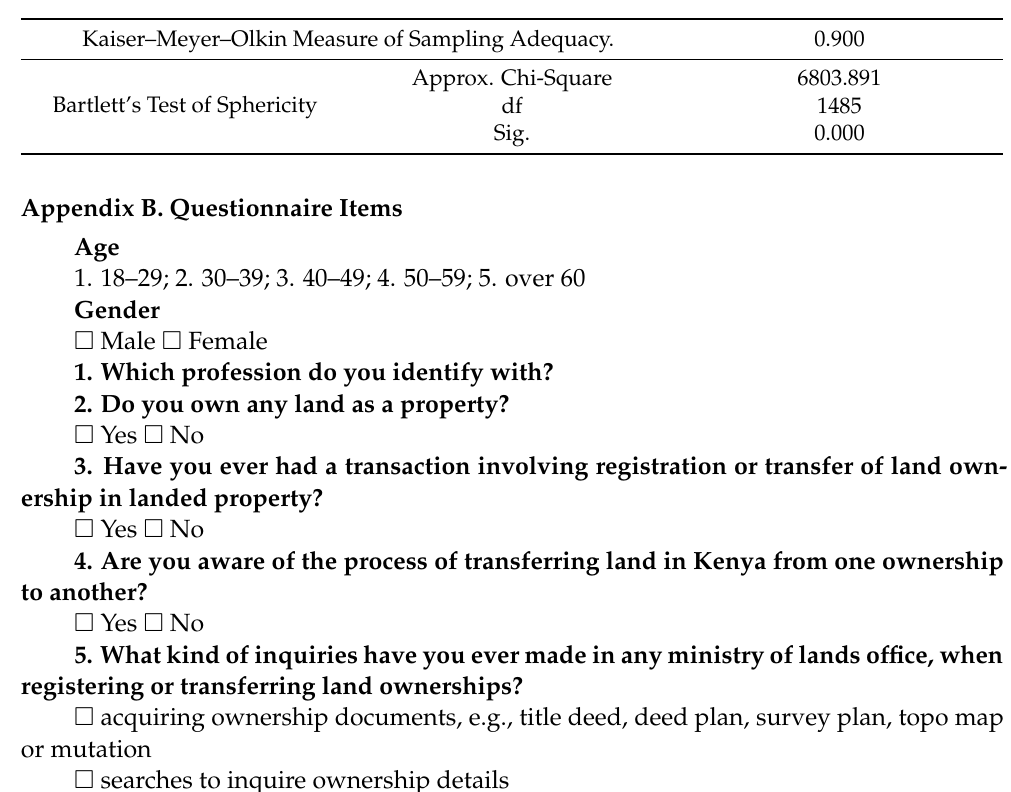
Table A5. KMO and Bartlett’s